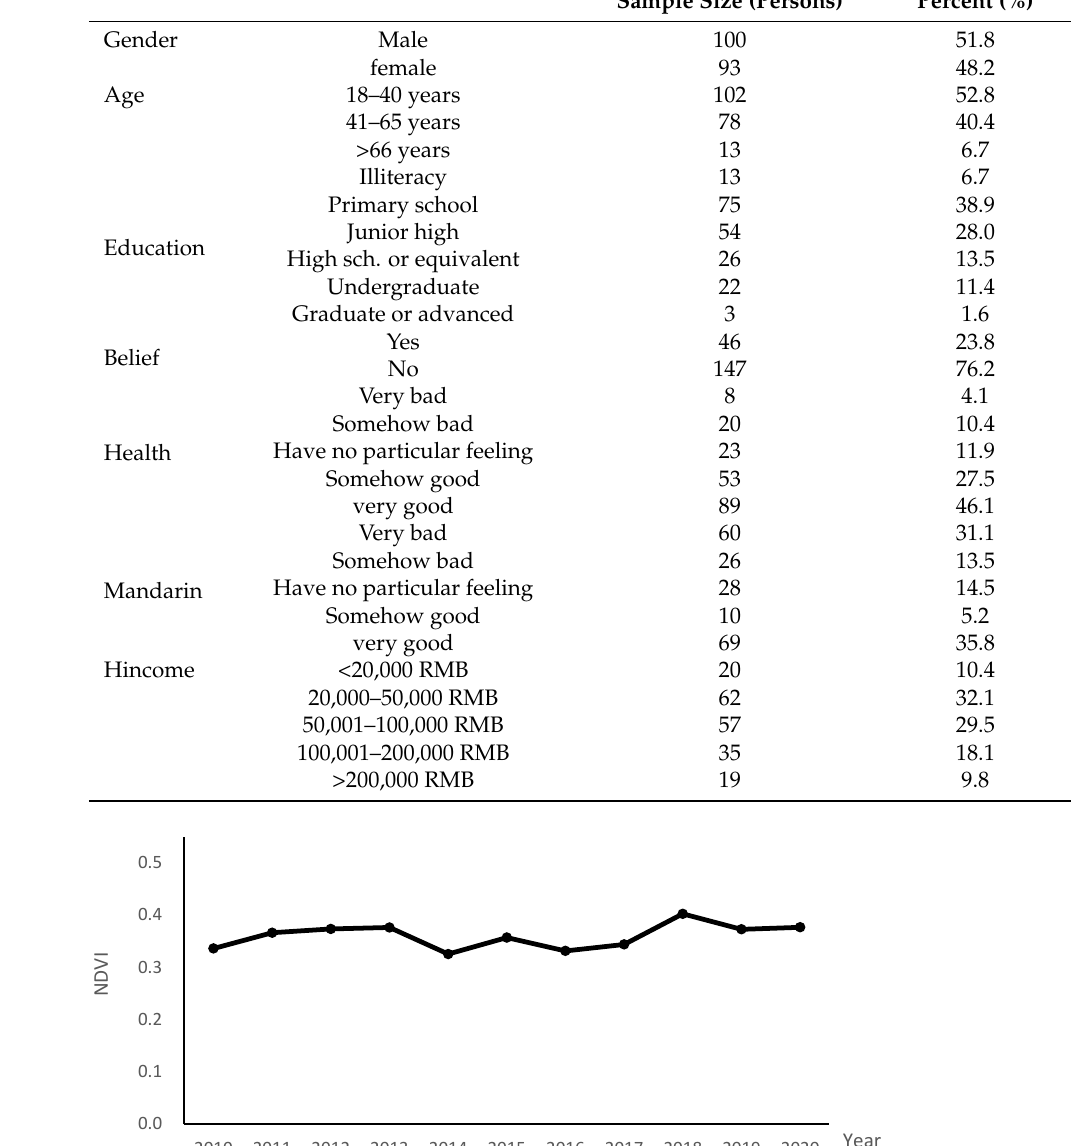
Figure 1. Grassland quality.